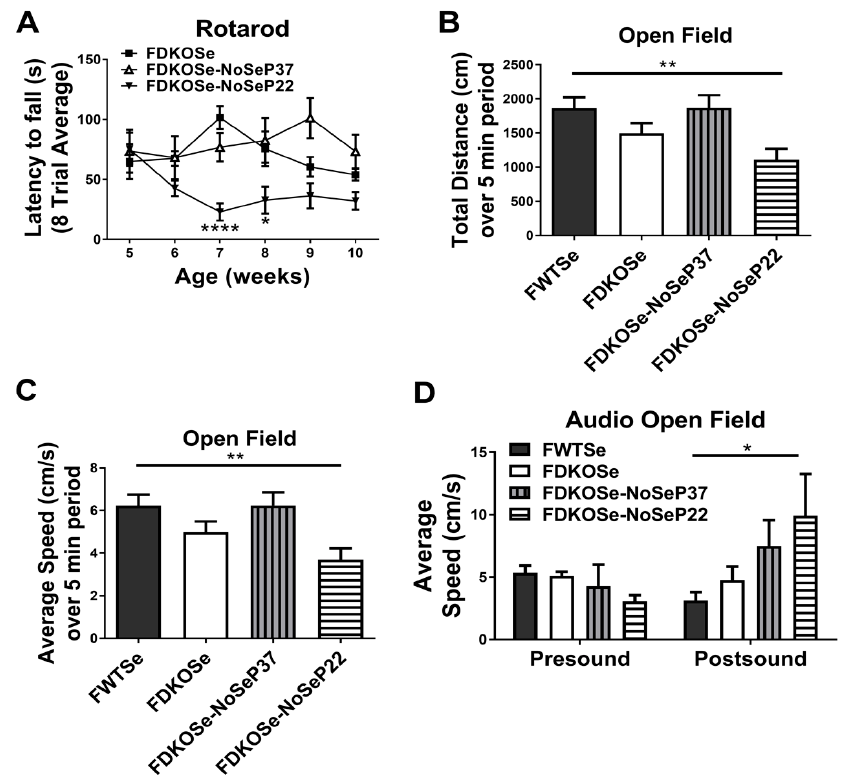
Figure 2. E ff ect of SeH 2 O withdrawal age on motor function and seizures in female double knockout mice supplemented with Se (FDKOSe). ( A ) Latency to fall during rotarod assay, ( B ) total distance traveled, and ( C ) average speed over 5-min period in the open field test, and ( D ) Average speed 2 1 / 2 min prior (presound) and 10 s after (postsound) 85 dB white noise played during open field sudiogenic seizure assay. Assays were carried out on female wild-type mice supplemented with Se (FWTSe), FDKOSe, FDKOSe-NoSeP37 (supplemental Se removed at P37), and FDKOSe-NoSeP22 mice at 10 weeks of age. ( A ) Rotarod two-way ANOVA: Females Interaction F (15,111) = 1.968, p = 0.0238, Genotype F (3,111) = 25.1, p < 0.0001, week NS; FWTSe, FDKOSe, and FDKOSe-NoSeP22, n = 6, NoSeP37, n = 4; *,**** indicate time-wise significant di ff erences between FDKOSe and FDKOSe-NoSeP22 according to Bonferroni’s multiple comparisons test. There were no significant di ff erences between FDKOSe and FDKOSe-NoSeP37 at any time point. FDKOSe-NoSeP37 values were significantly higher than FDKOSe-NoSeP22 at 7(*), 8(*), 9(**), and 10(*) weeks. ( B – D ). Open field one-way ANOVA: Distance p = 0.0084, Average Speed, p = 0.0084, FWTSe and FDKOSe n = 12, P37 n = 7, P22 n = 10; Audio open field two-way ANOVA: Interaction NS, n = 11 all groups except FDKOSe-NoSeP37, n = 4; Bonferroni’s multiple comparisons test: * p < 0.05, ** p < 0.01). All values reported as mean ±